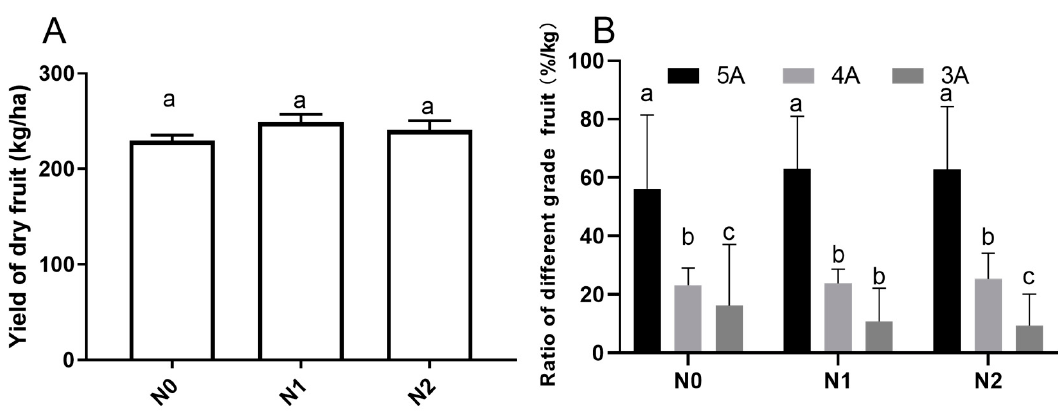
Figure 1. Yield and commodity grade of goji fruits under different Nitrogen fertilizations. Small letters indicate a significant difference ( p < 0.05), as analyzed by Duncan’s multiple tests. The grading standard of the commodity grade of goji berry is according to the state council, the Ministry of Commerce and Health, GBT18672-2014 and other relevant national standards, as well as the particle size. The number of particles contained in 50 g fruits are: 5A—180 particle/50g; 4A—220 particle/50g; 3A—280 particle/50 g; 2A means inferior fruits, which not shown in the bar graph. ( A ) Yield of goji dry fruit; ( B ) Ratio of different grade goji fruit.